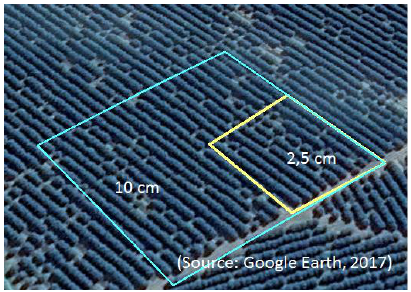
Figure 2. Aerial surveyed area is the yellow polygon region.